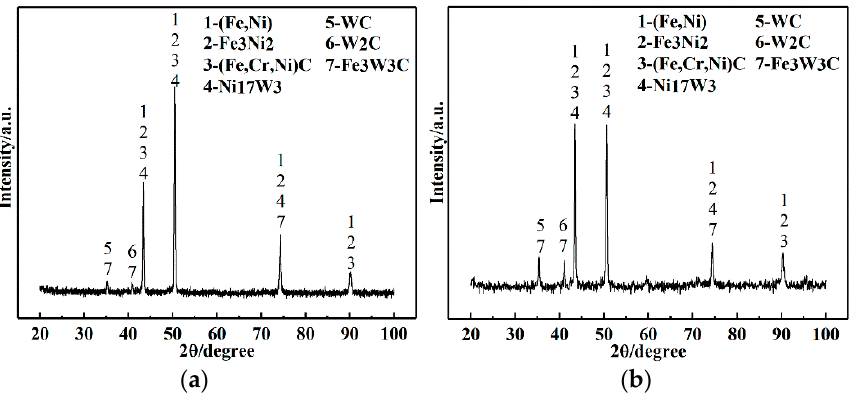
Figure 4. XRD patterns of coatings ( a ) without ultrasonic vibration and ( b ) with ultrasonic vibra- tion.